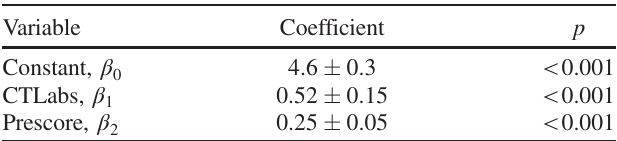
TABLE IX. Linear model for PLIC postscore as a function of lab treatment and